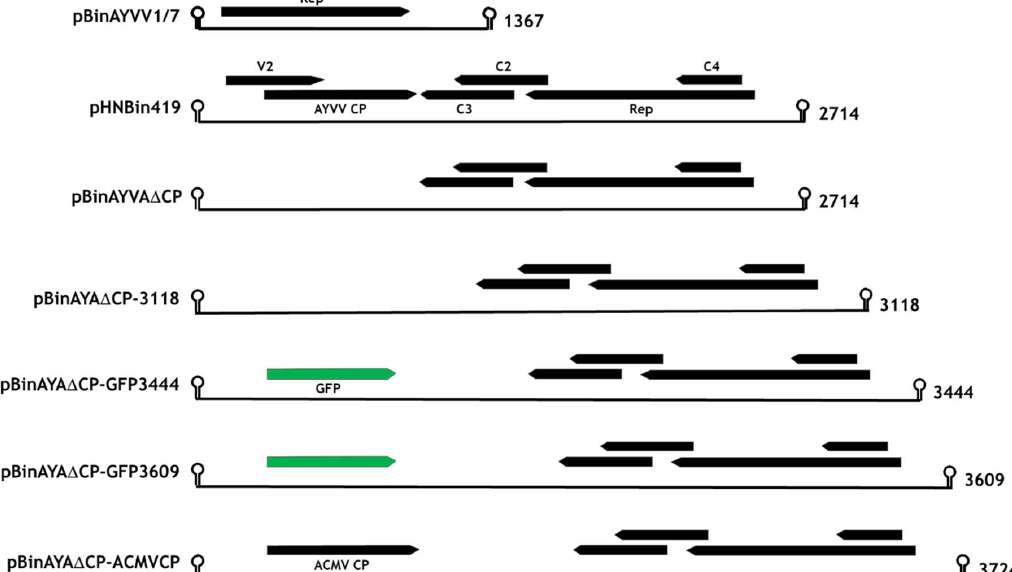
Figure 1. Linear representation of the replicating gene constructs with the known or predicted circular length, in nucleotides, for each displayed on the right. CP, coat protein; Rep, viral protein involved in rolling circle replication; C2, C3, C4, and V2, viral genes. GFP, green fluorescent protein.